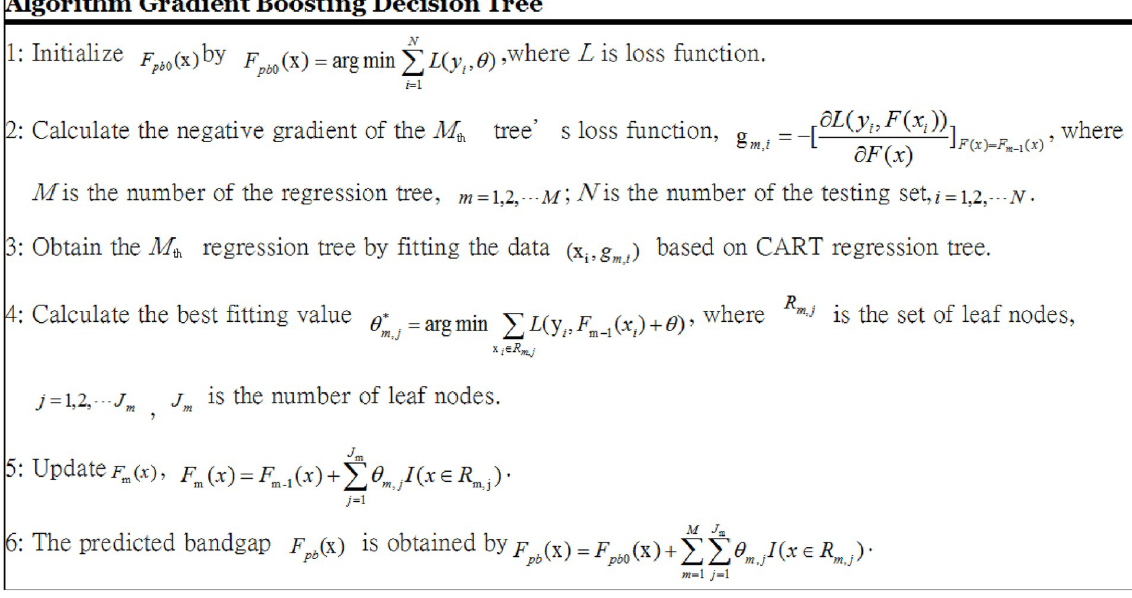
Fig 1. Gradient boosting decision tree algorithm.